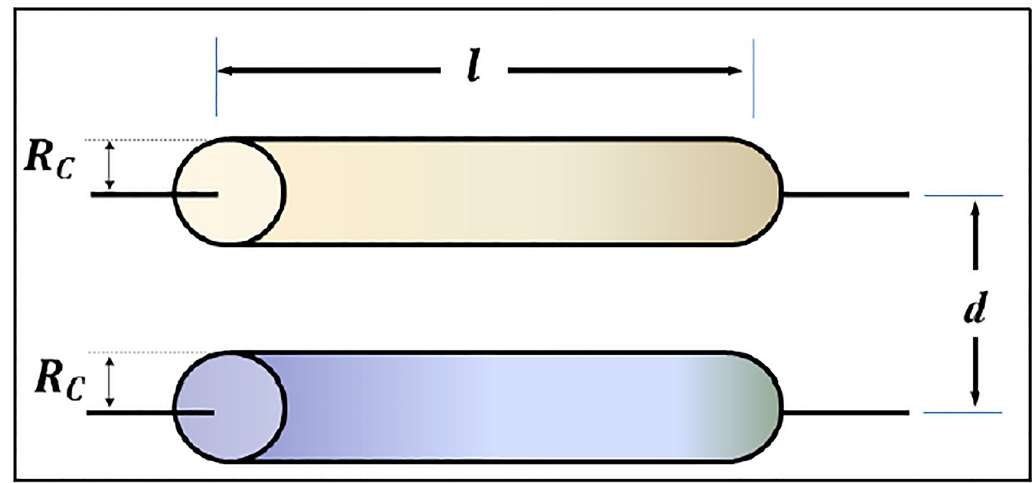
Fig 8. Features of two parallel conductors.